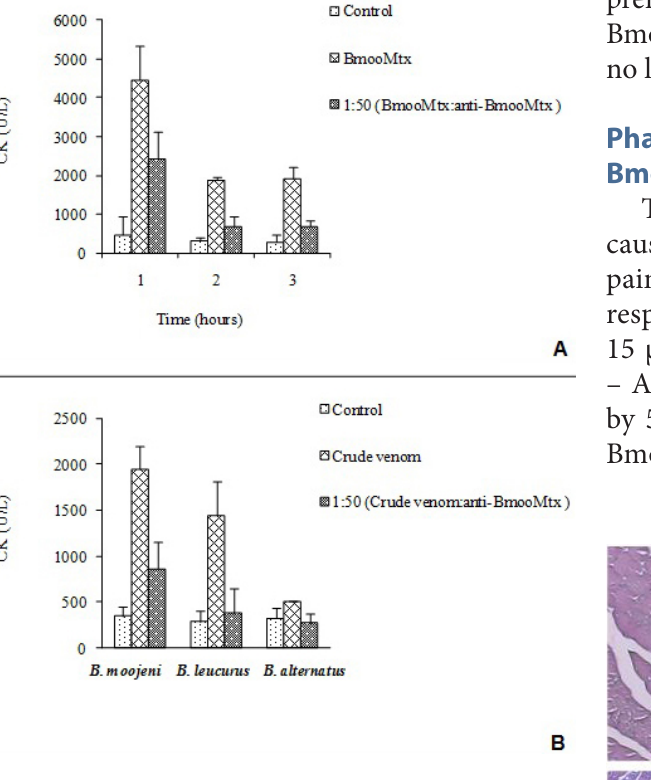
Figure 2. Neutralization of (A) the myotoxic activity of BmooMtx and (B) crude venoms preincubated for 120 minutes at 37°C with anti-BmooMtx antibodies at the ratio 1:50 (w:w). Control mice received saline alone. Injections were performed in the gastrocnemius muscle and plasma CK activity was determined at three hours (crude venoms) and at 1, 2 and 3 hours (BmooMtx). Activity was expressed in units/L and results are presented as a mean of five experiments.